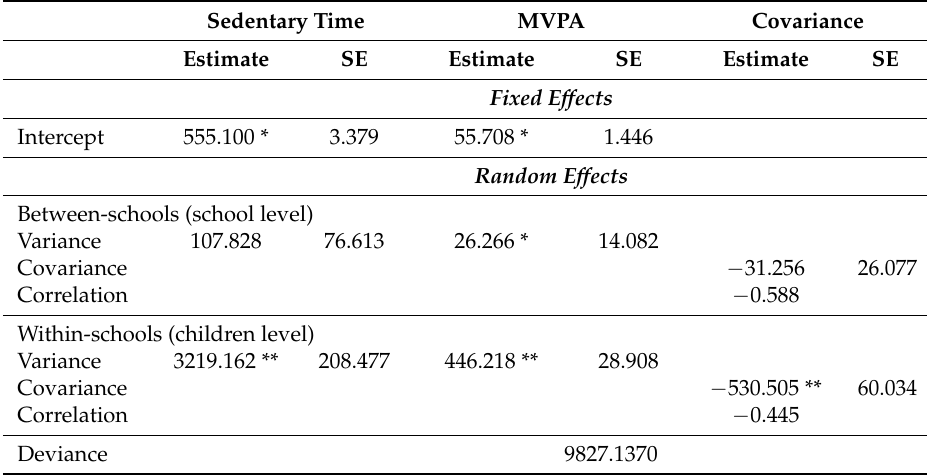
Table 3. Model 1 main results (parameter estimates, Standard Errors (SE), and deviance) for both sedentary time and